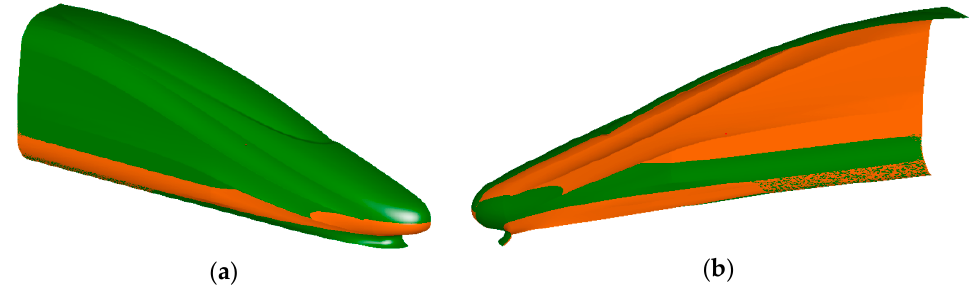
Figure 13. Comparison of the streamlined shape between the prototype and the optimal shape. ( a ) View from the direction of positive y ; and ( b ) view from the direction of negative y .